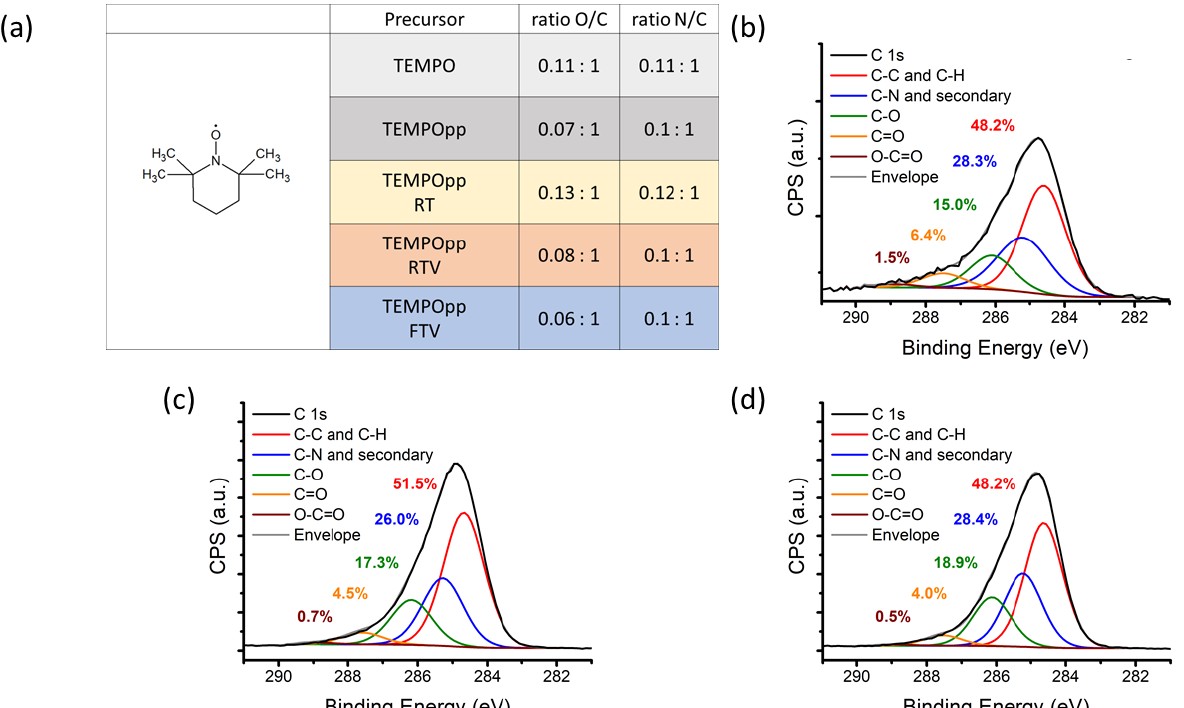
Figure 4. ( a ) Atomic composition of TEMPOpp RT, RTV and FTV. High resolution C 1s spectrum of TEMPOpp stored at RT ( b ), RTV ( c ) and FTV ( d ) for 15